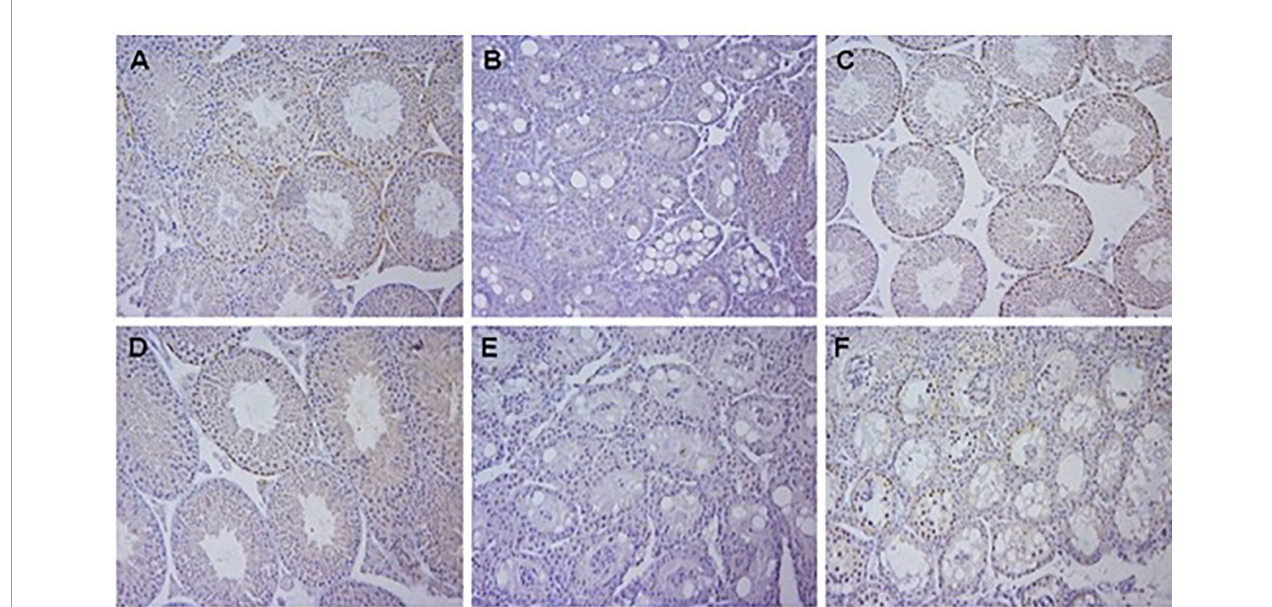
FIGURE 1 | Histology of testis of mice with gene deletions in Aldh1a1 and Aldh1a2 . All samples were Bouin ’ s fi xed, embedded in paraf fi n, cut into 4 µm sections and either stained with hematoxylin and eosin and immunohistochemistry was performed using primary antibodies to Stra8. (A) Aldh1a1 -/- , Aldh1a2 -/+ 4 week old mice showing normal histology with sperm and Stra8 positive spermatogonia and preleptotene spermatocytes. (B) 4 week old mice with genotype of Aldh1a1 -/- , Aldh1a2 -/- after crossing mice in (A) with AMH-Cre mice resulting in deletion in Sertoli cells and a complete block at the progression of undifferentiated spermatogonia. (C) Mice with deletion in Sertoli cells as shown in (B) 42 days after a single injection of RA. Note recovery of normal spermatogenesis and partial synchrony of Stra8 expression. (D) 4 week old mice with genotype of Aldh1a1 -/- , Aldh1a2 -/- after crossing mice in (A) with Stra8-Cre mice resulting in deletion in germ cells. Note normal histology. (E) 4 week old mice with genotype of Aldh1a1 -/- , Aldh1a2 -/- after crossing mice in (A) with both AMH-Cre mice and Stra8-Cre mice resulting in deletion in both Sertoli cells and germ cells. (F) 4 week old mice with genotype of Aldh1a1 -/- , Aldh1a2 -/- after crossing mice with ERT-Cre mice and treatment with tamoxifen starting at postnatal day 8 and again at postnatal day 21 as described in the methods. Results illustrate the early block between A and A1 spermatogonia when RA is not